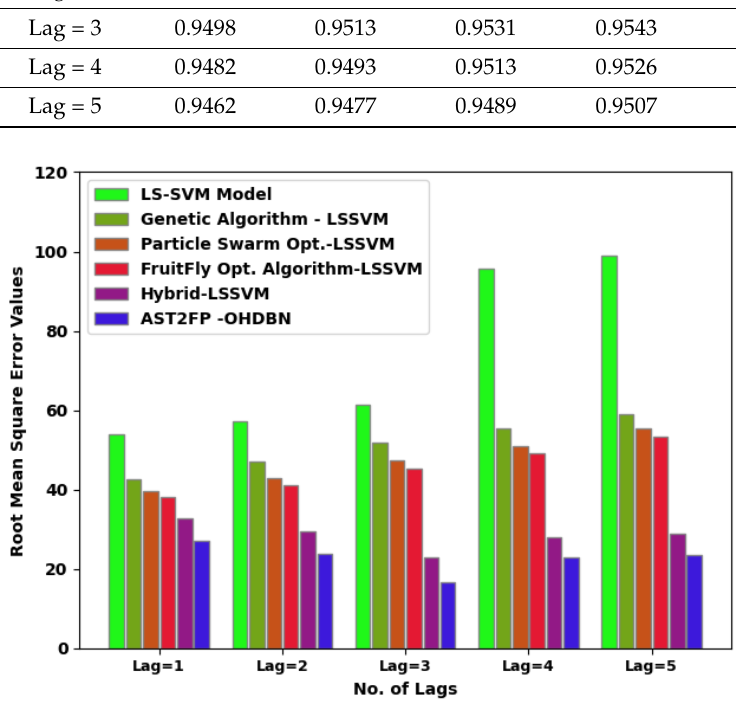
Figure 5. RMSE analysis of AST2FP-OHDBN approach with existing methodologies.